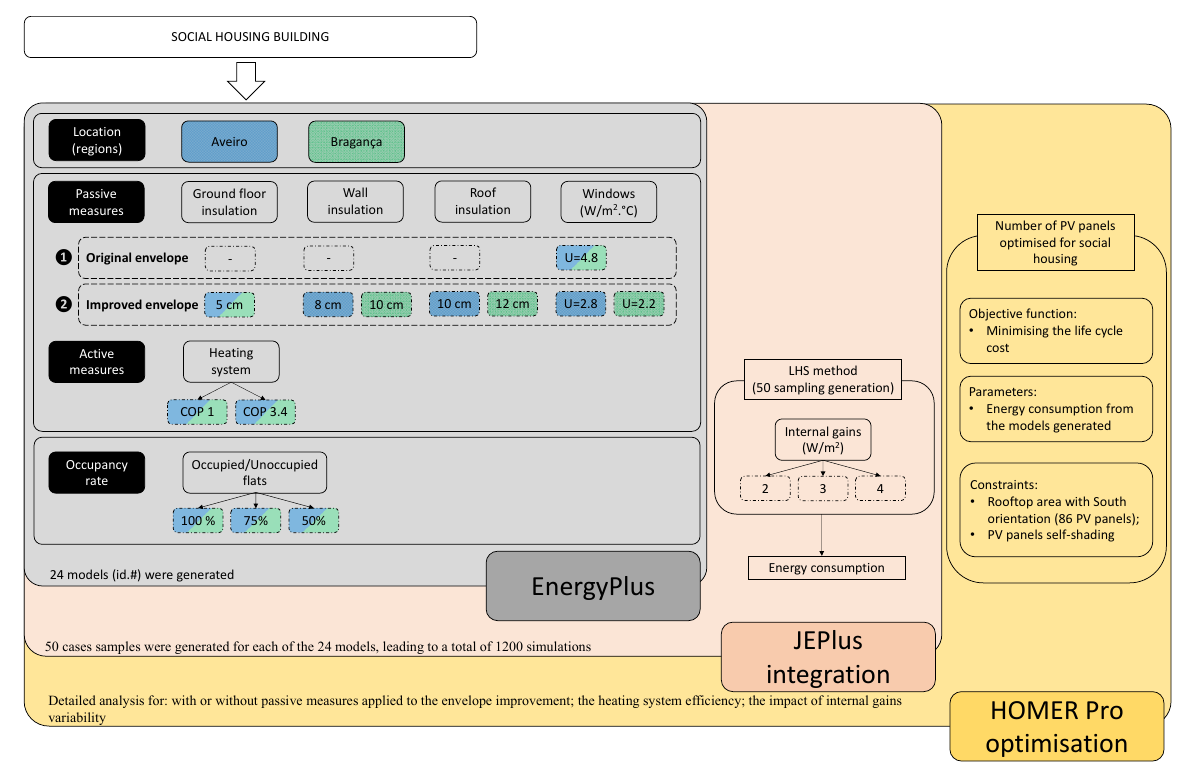
Figure 4. Schematic diagram of the methodology.